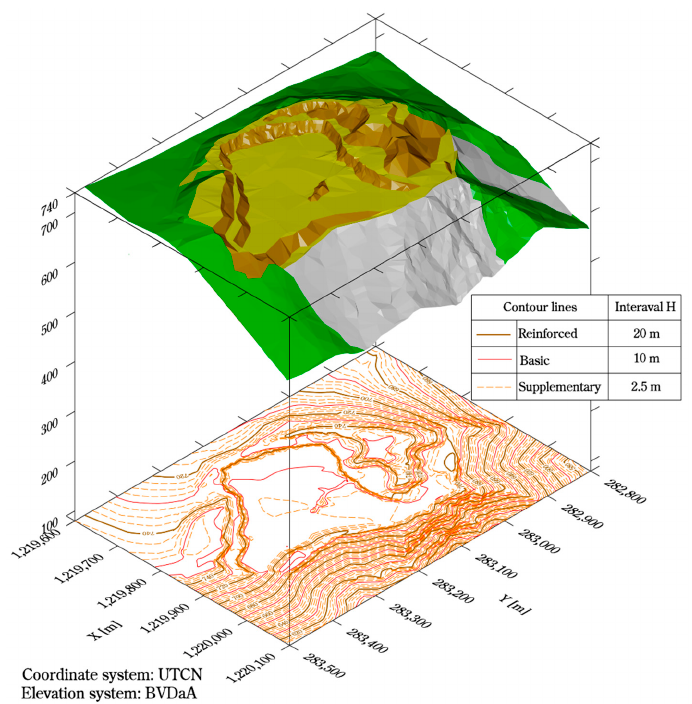
Figure 10. Graphical representation of the contour and TIN model of the open-pit mine with the application of colour resolution of the territory